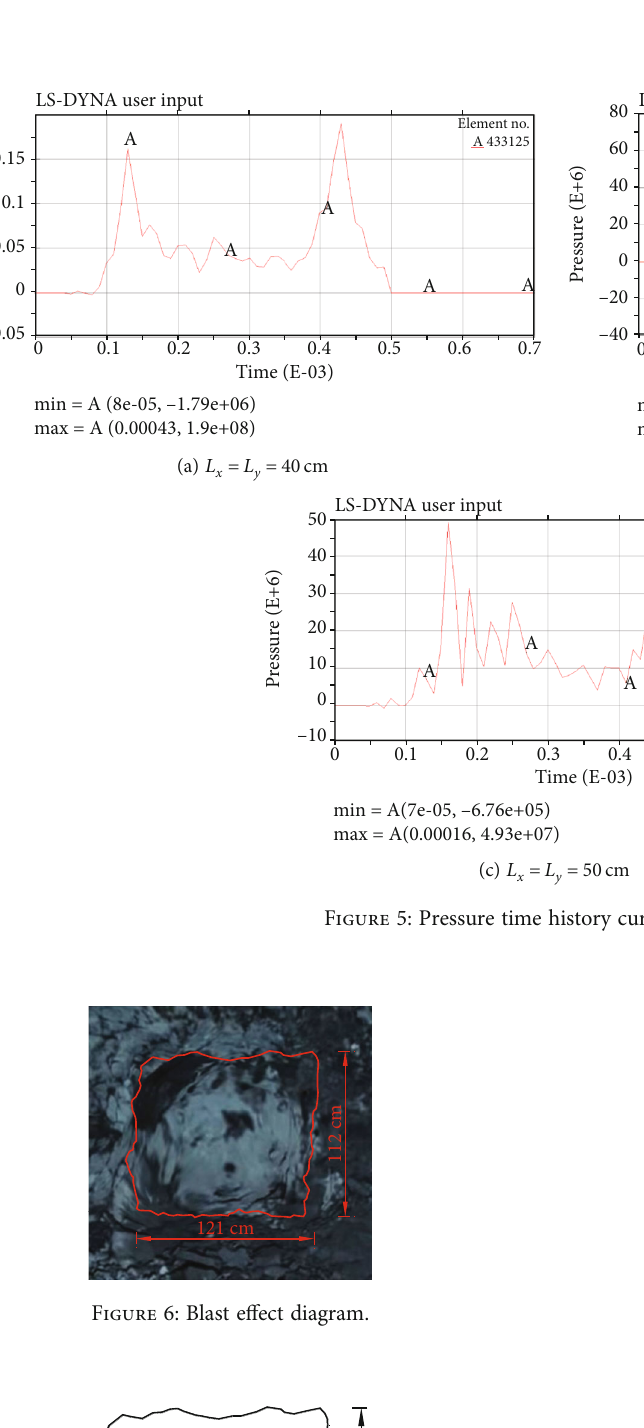
Table 9: Blast e ff ect statistic